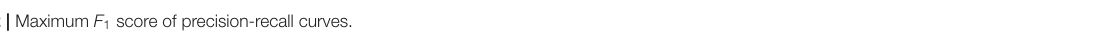
TABLE 2 | Maximum F 1 score of precision-recall curves. Dataset